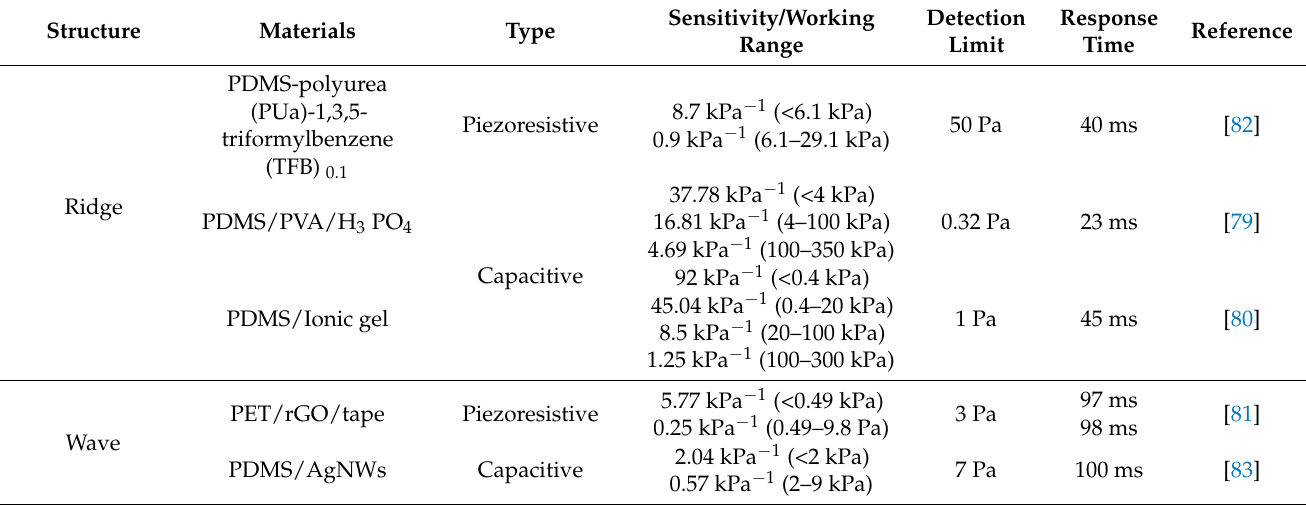
Table 4. The summary of sensor performances with wave/ridge